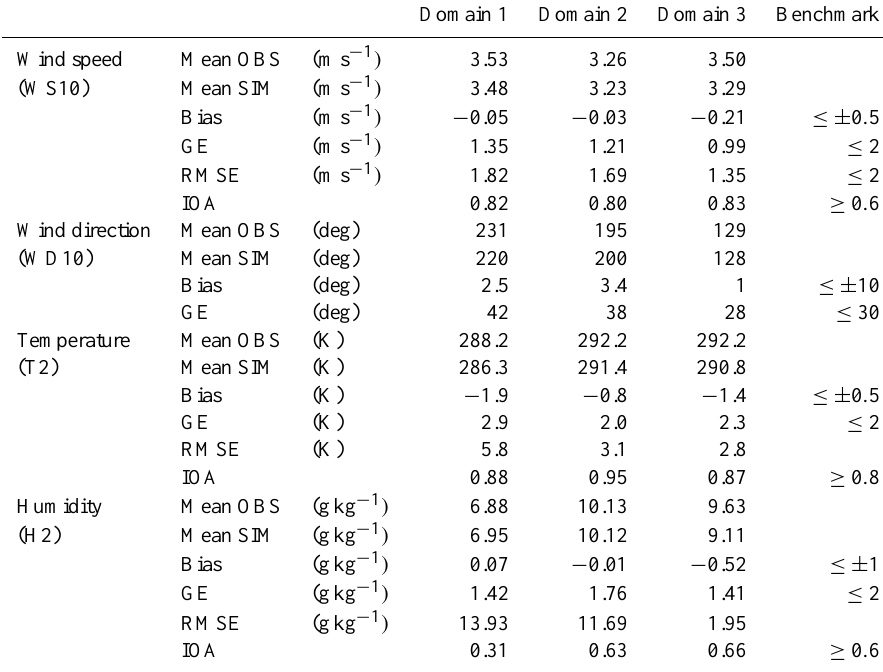
Table 3. Performance statistics of meteorological variables. See text for abbreviation